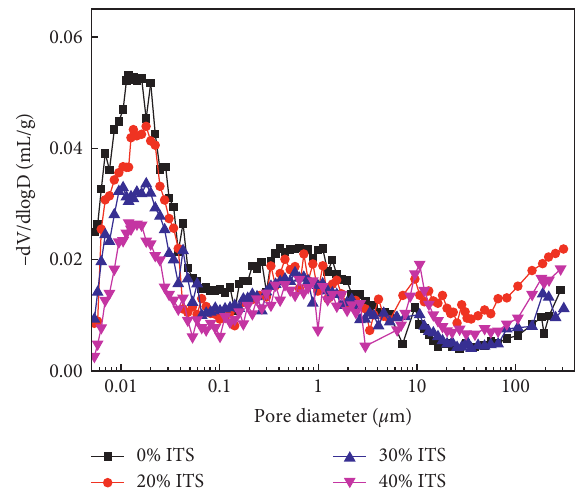
Figure 13: Relationship between the incremental saturation of mercury and the aperture.